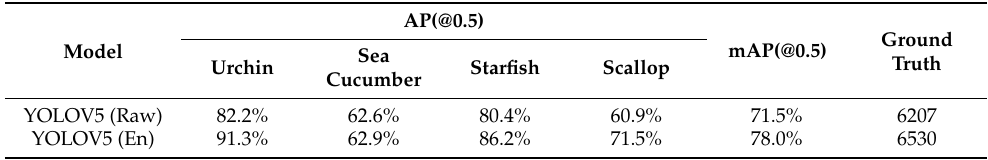
Table 1. Performance comparison of image enhancement module.